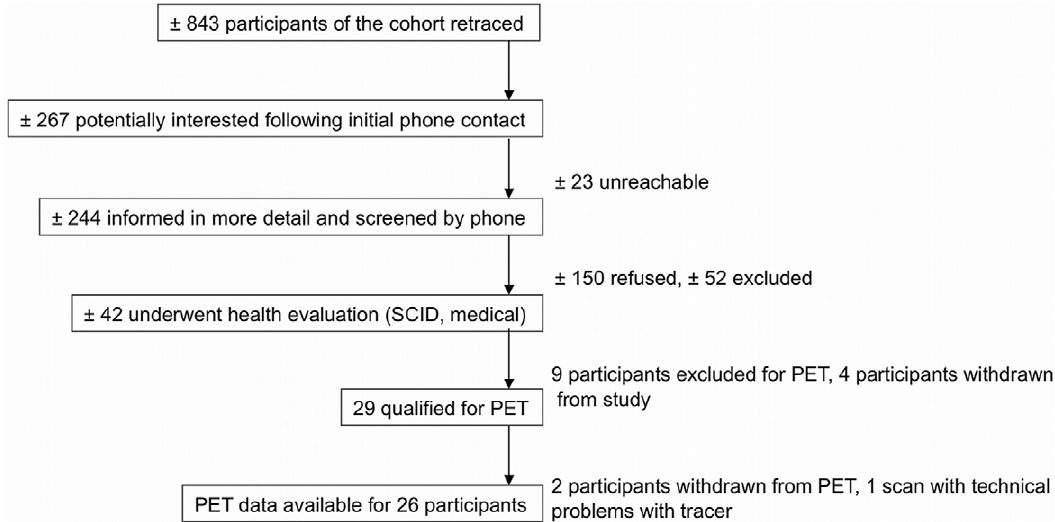
Figure 3. Schematic overview of the recruitment process.